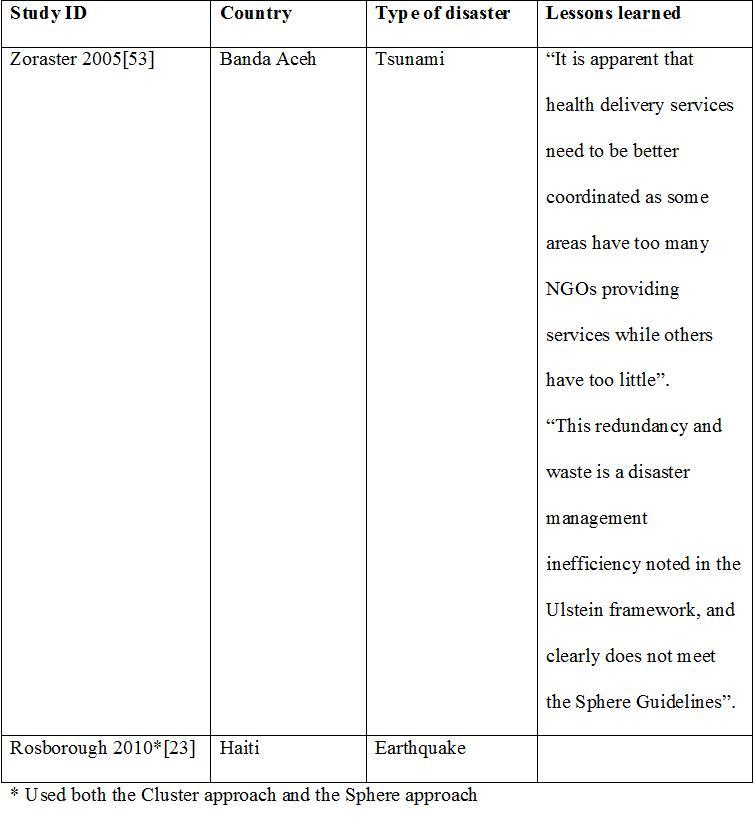

The Sphere Project